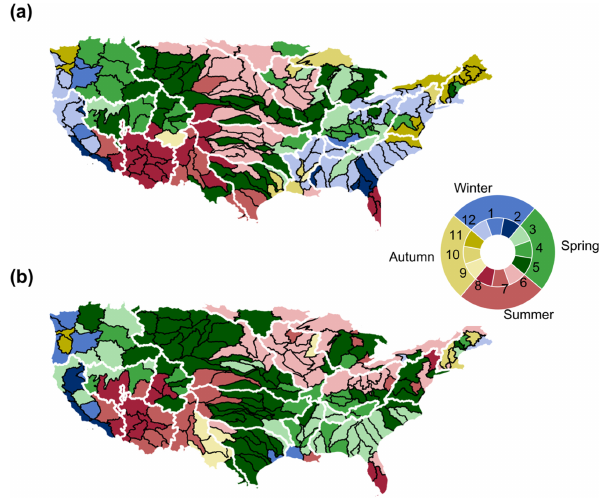
Figure 4. Maps of month of maximum flood frequency, same as Fig. 3a but for two periods: (a) 2000–2010 and (b) 2010–2020.